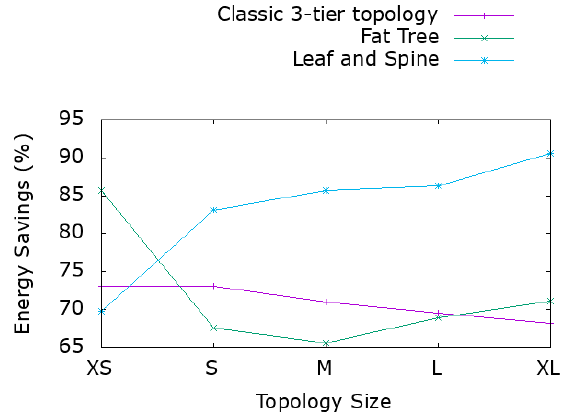
Figure 2. Energy savings for various network topologies and sizes.